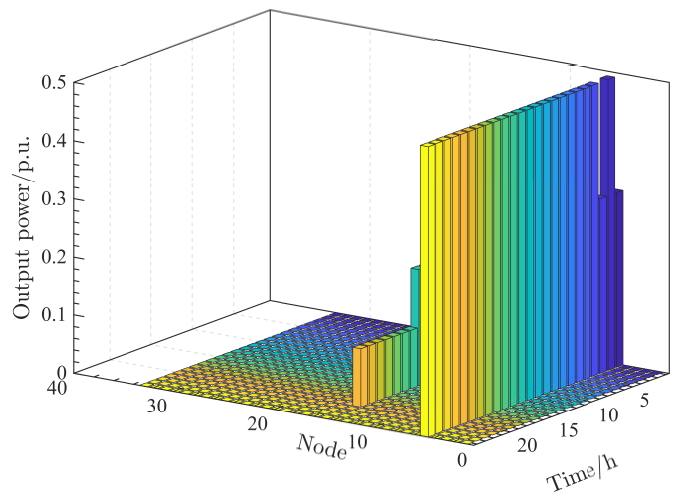
Figure 11. CB Spatial and temporal distribution of power output.